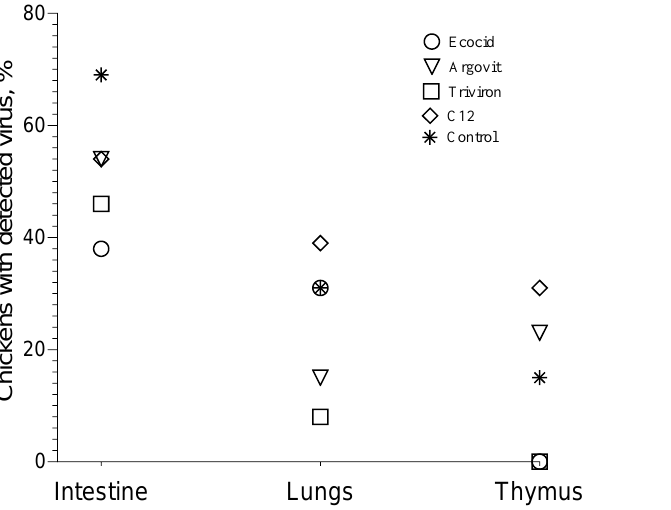
Figure 5. The percentage of chickens with virus detected in intestine, lungs, and thymus for all studied groups.